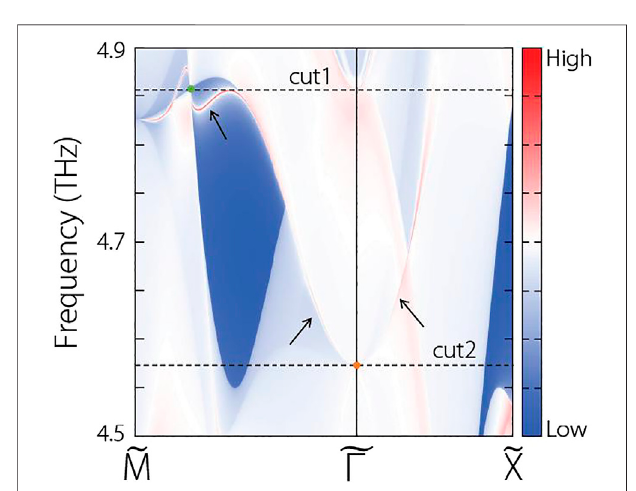
FIGURE 5 | Calculated surface states along the (cid:1) M − (cid:1) Γ − (cid:1) X paths of the (001)